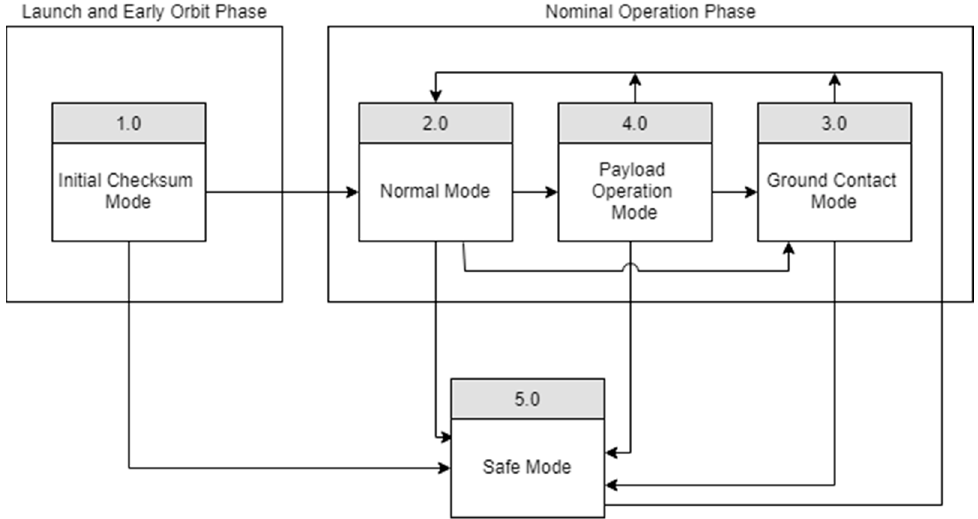
Figure 4. Overall modes of MeznSat operations.